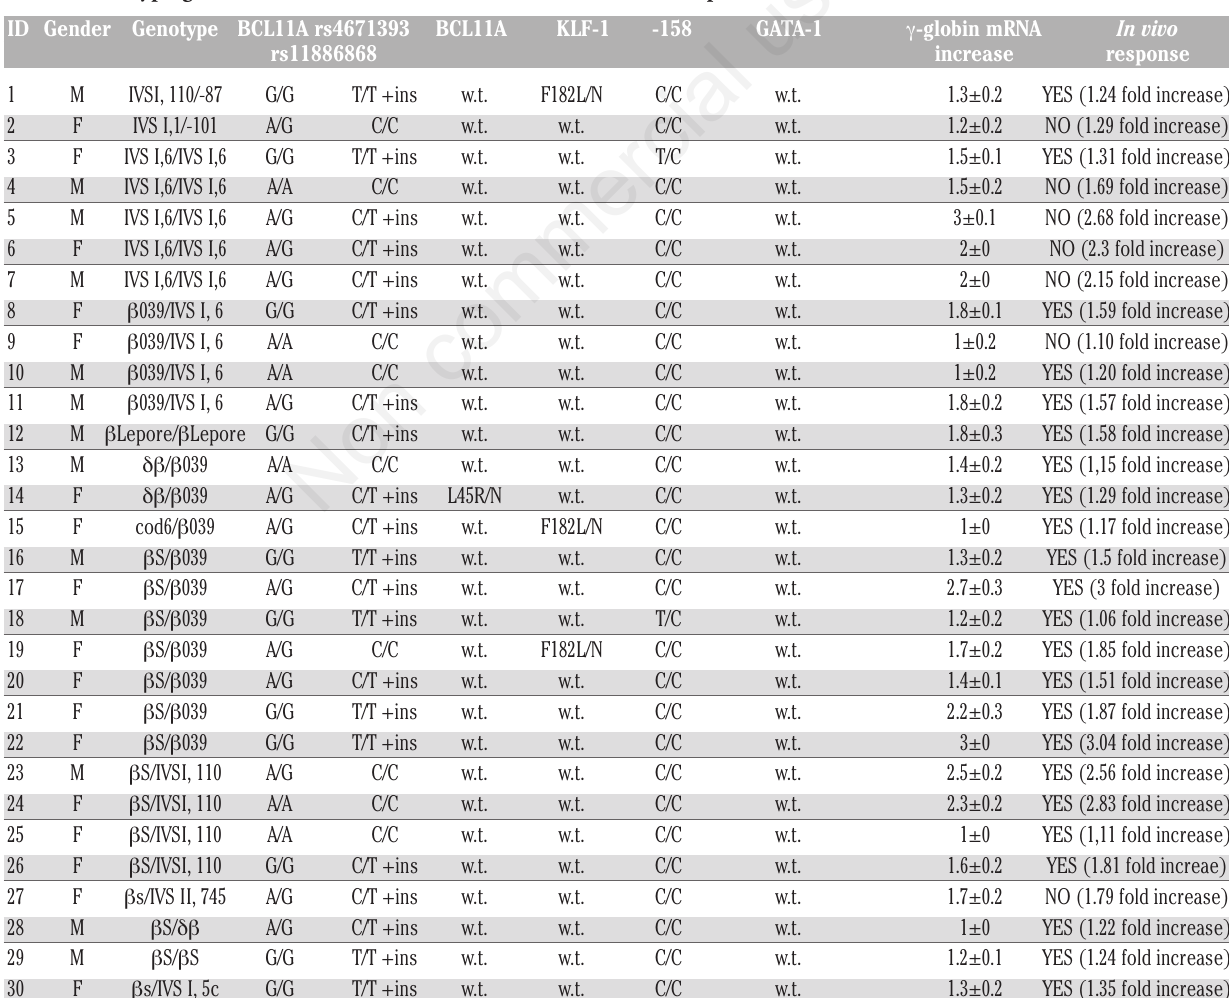
Table 1. Genotyping results and correlation between in vitro and in vivo